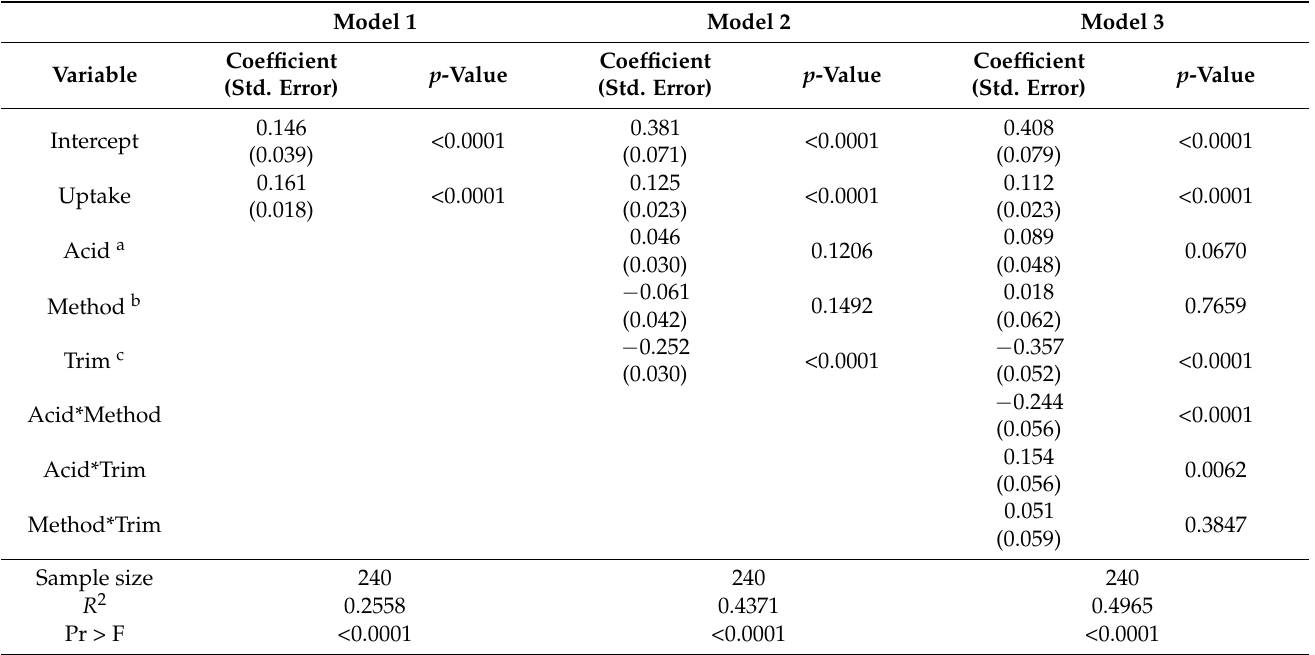
Table 2. Estimated linear regression coefficients for Salmonella spp. reduction (n = 240) with main effects and interactions between explanatory